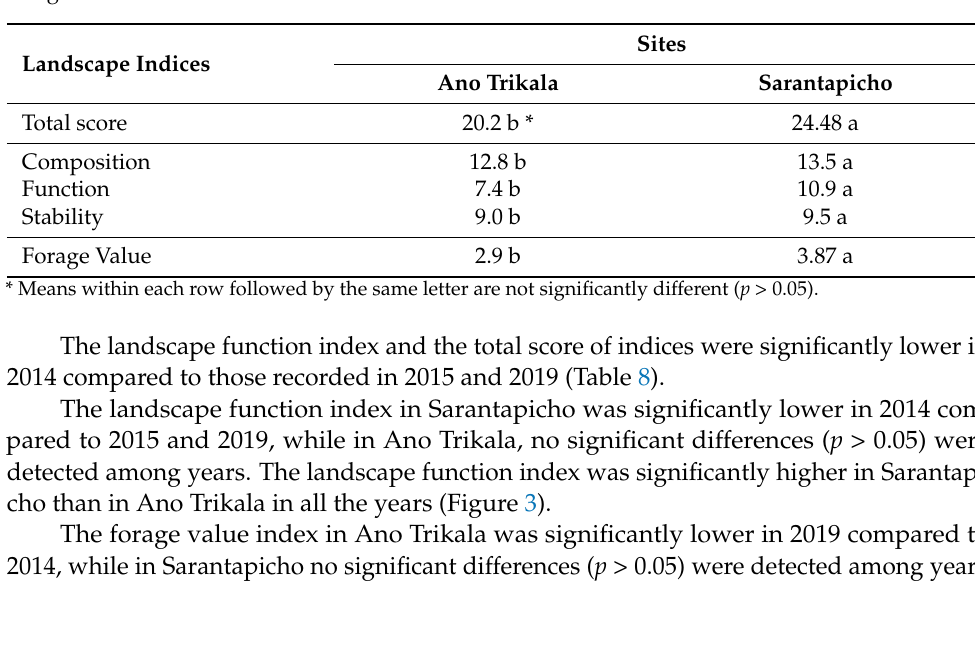
Table 7. Effects of site (across years) on indices of landscape composition, function, stability, and forage value